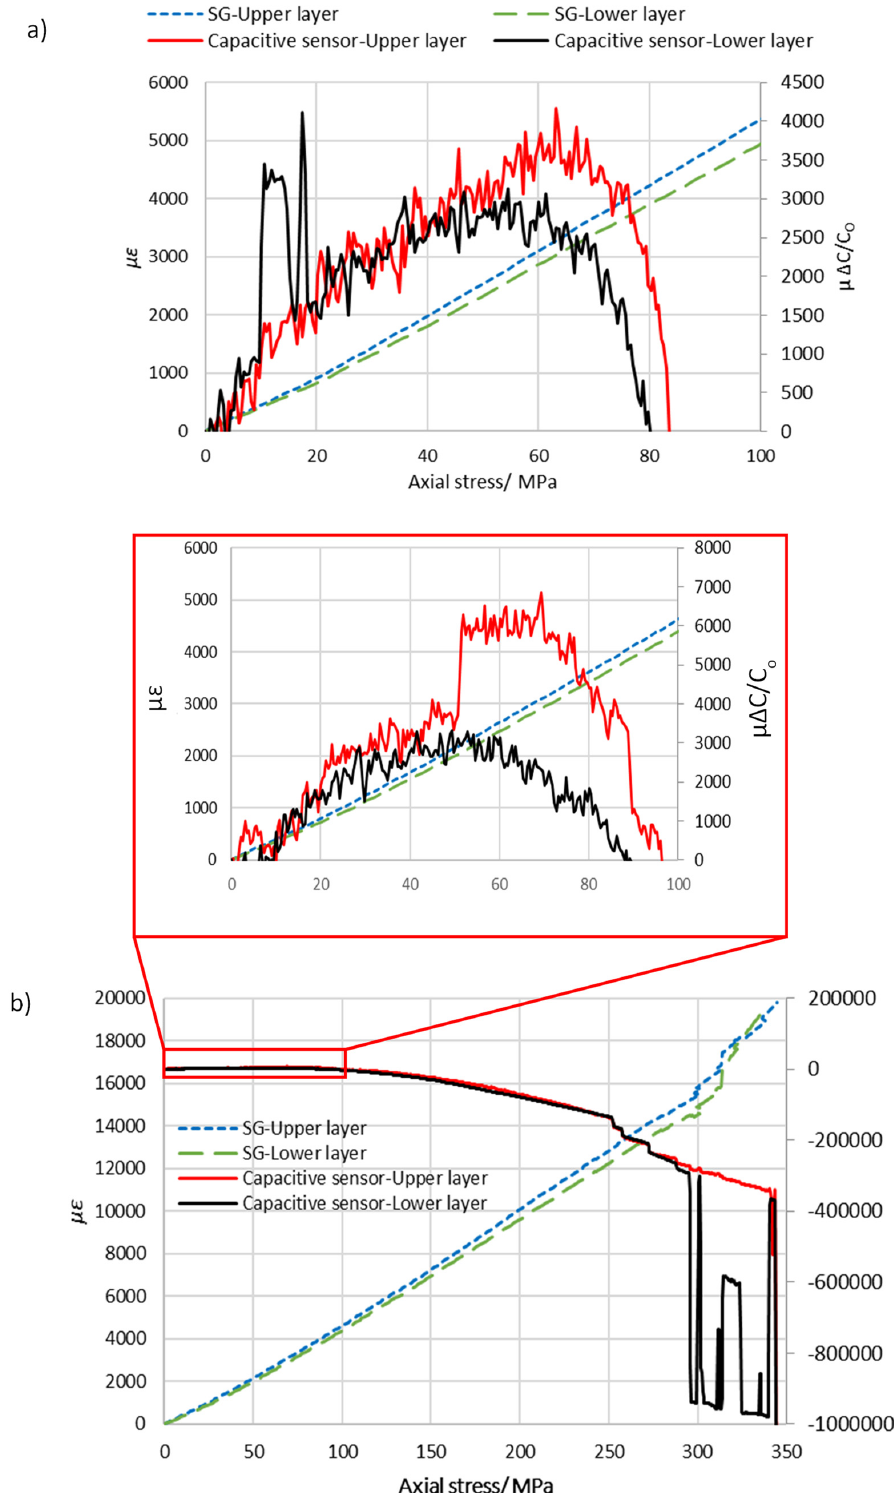
Figure 8. A plot of relative change in capacitance and nominal strain against the axial stress for the type-B configuration. Graph ( a ) shows the experimental results for sample B-1, where ranges of the x- and y-axes were limited to 100 MPa and 6000 µ ɛ . ( b ) The result shows sample B-2 pulled to breaking point and the inset in graph ( b ) shows an enlarged view where the ranges of the x- and y-axes were limited to 100 MPa and 6000 µ ɛ .